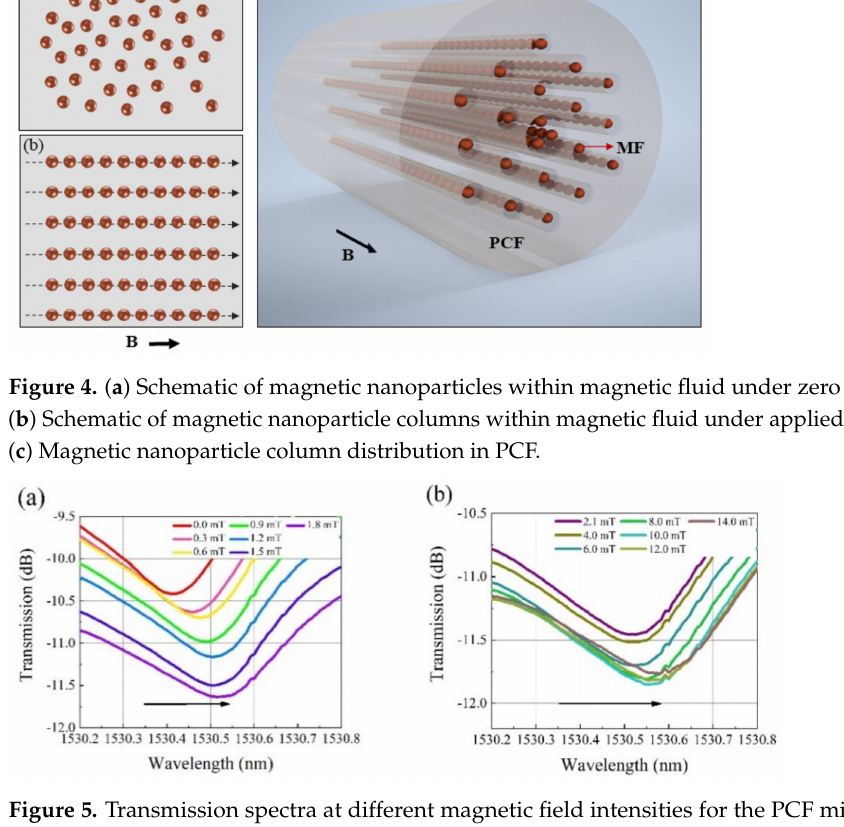
Figure 5. Transmission spectra at different magnetic field intensities for the PCF microcavity with diameter of 67 µ m. The magnetic field strength is in the range of ( a ) 0 to 1.8 mT and ( b ) 2.1 to 14 mT.